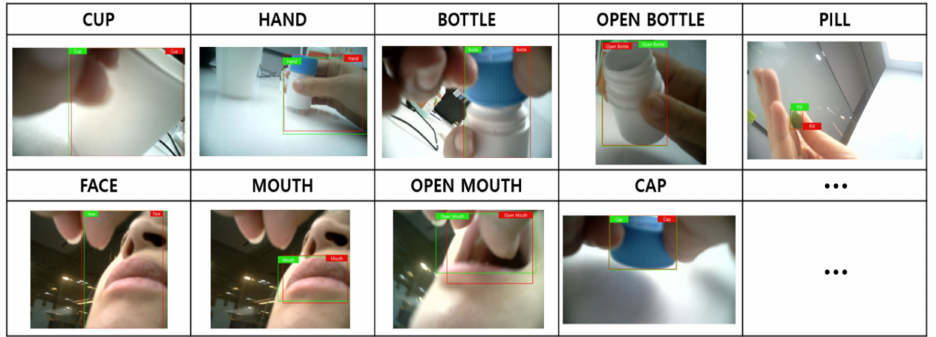
Figure 9. Object detection examples for Model